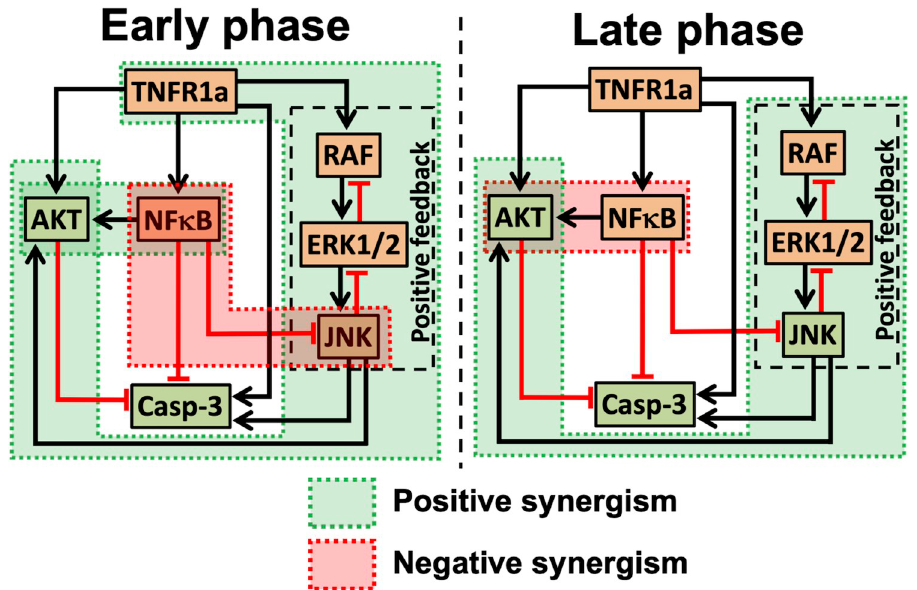
Fig 8. Comparison of time-dependent synergism during the early and late phase signaling cross-talk regulating Caspase3 activation.